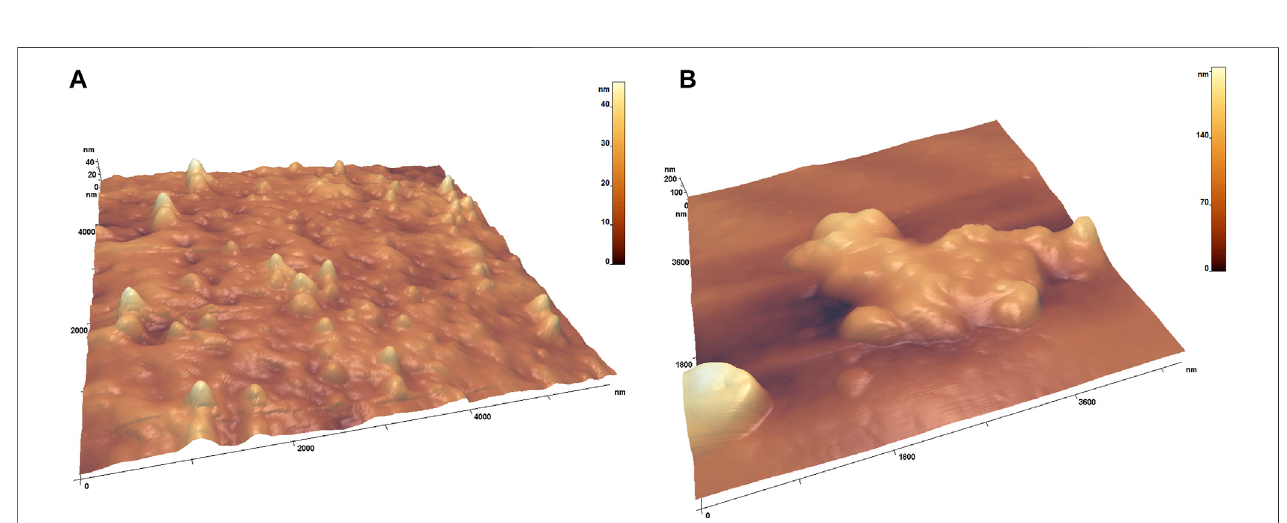
FIGURE 9 | Atomic force microscopy images of the in fl uenza A viruses that passed the membrane (A) and were retained by the membrane (B) . The maximum height on the A image is in the rate of 30 – 40 nm; on the B image, it is nearly 180 – 200 nm.